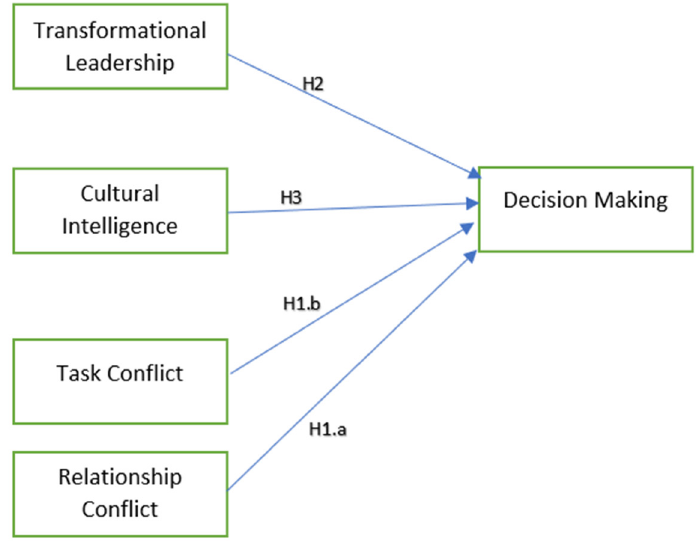
Figure 1. Factors affecting decision